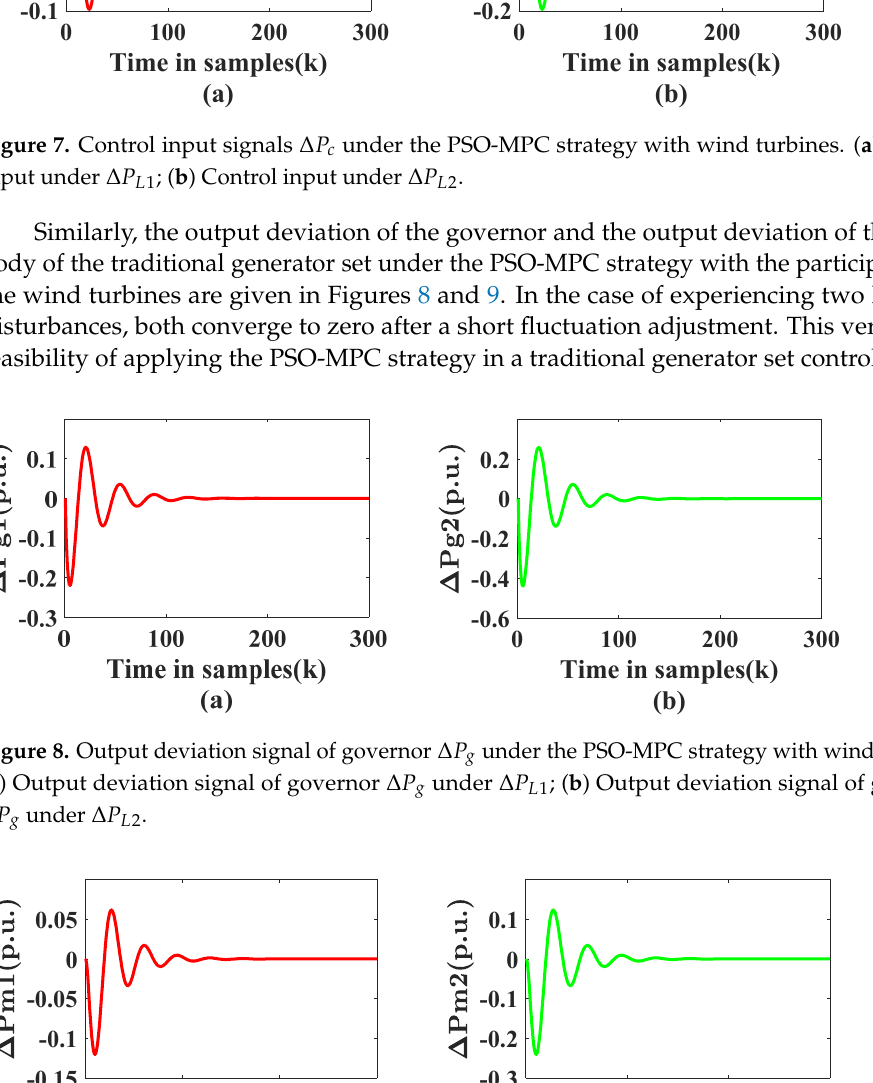
Figure 7. Control input signals ∆ P c under the PSO-MPC strategy with wind turbines. ( a ) Control input under Δ P L 1 ; ( b ) Control input under Δ P L 2 .